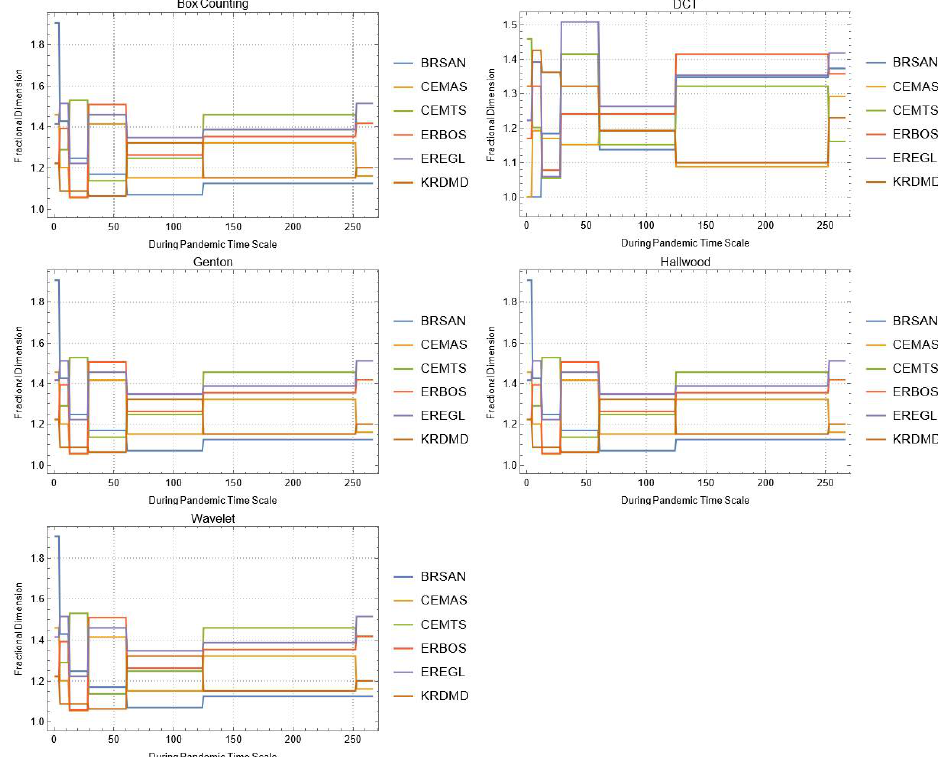
Figure A3. Daily changes of fractal dimensions during the pandemic (real estate).